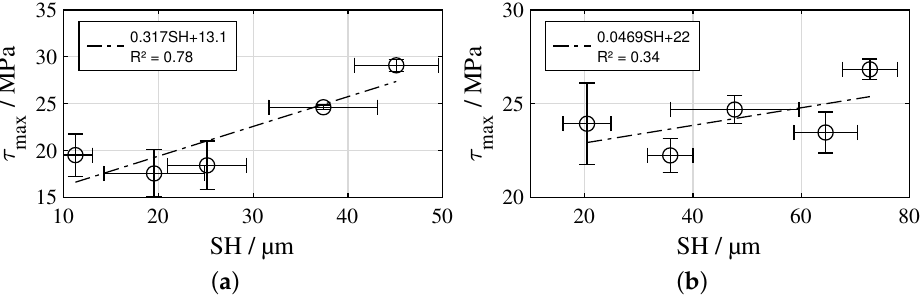
Figure 9. Correlation between SH and τ max : ( a ) L12 structures, ( b ) L40 structures; mean values ±